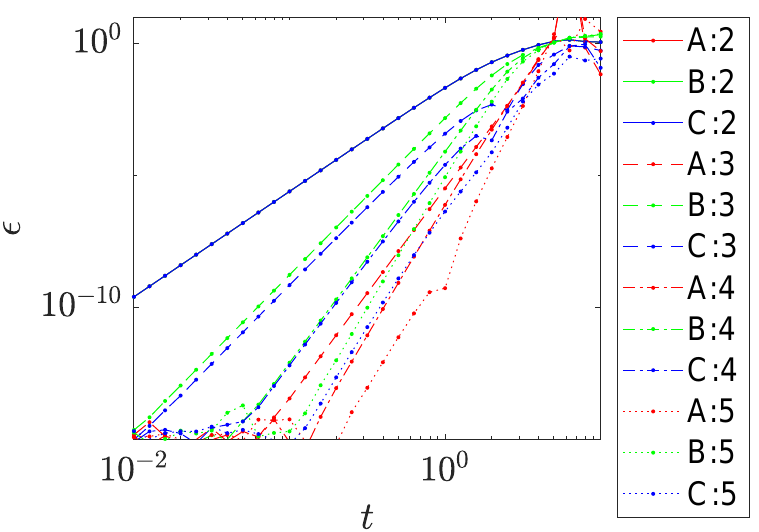
Figure 3: Unitarity error ε as a function of time t for the 1-D spin-1 / 2 Heisenberg model. We show results of the cluster-expansion TNO of type A,B and C with clus- tersize c =